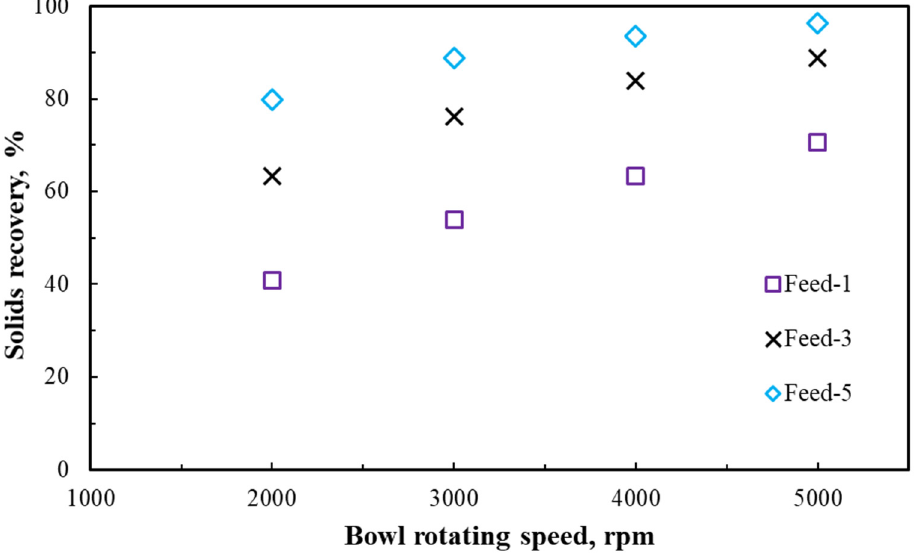
Figure 3. The relationship between the bowl rotating speed and solids recovery, with different feeds.